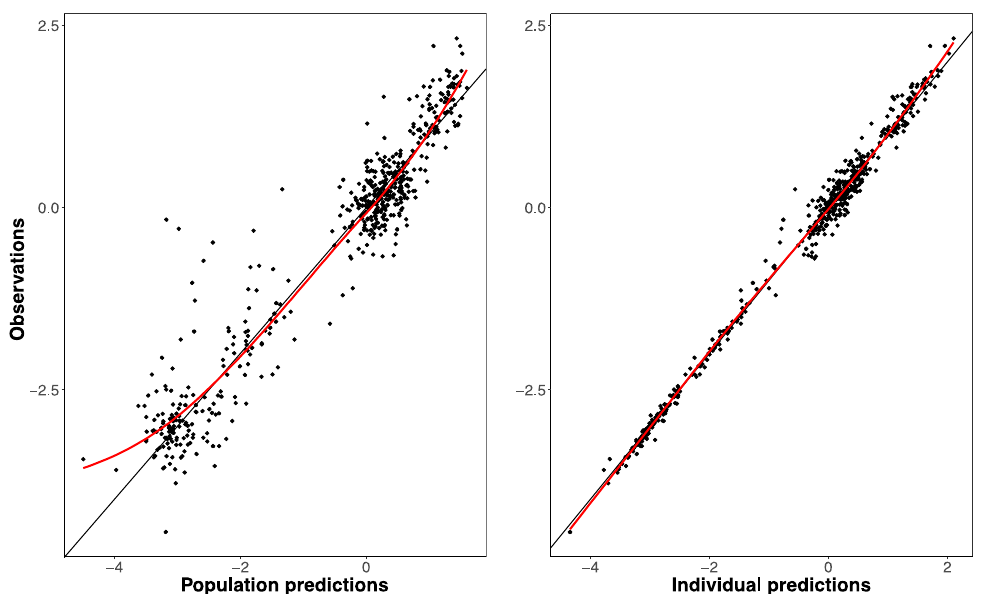
Figure 1. Goodness-of-fit plots presenting: BSA model predictions ( left panel ) or individual Bayesian predictions ( right panel ) versus observed paclitaxel concentrations, depicted using log transformed data.